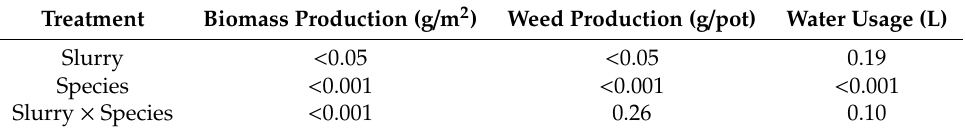
Table 4. ANOVA of